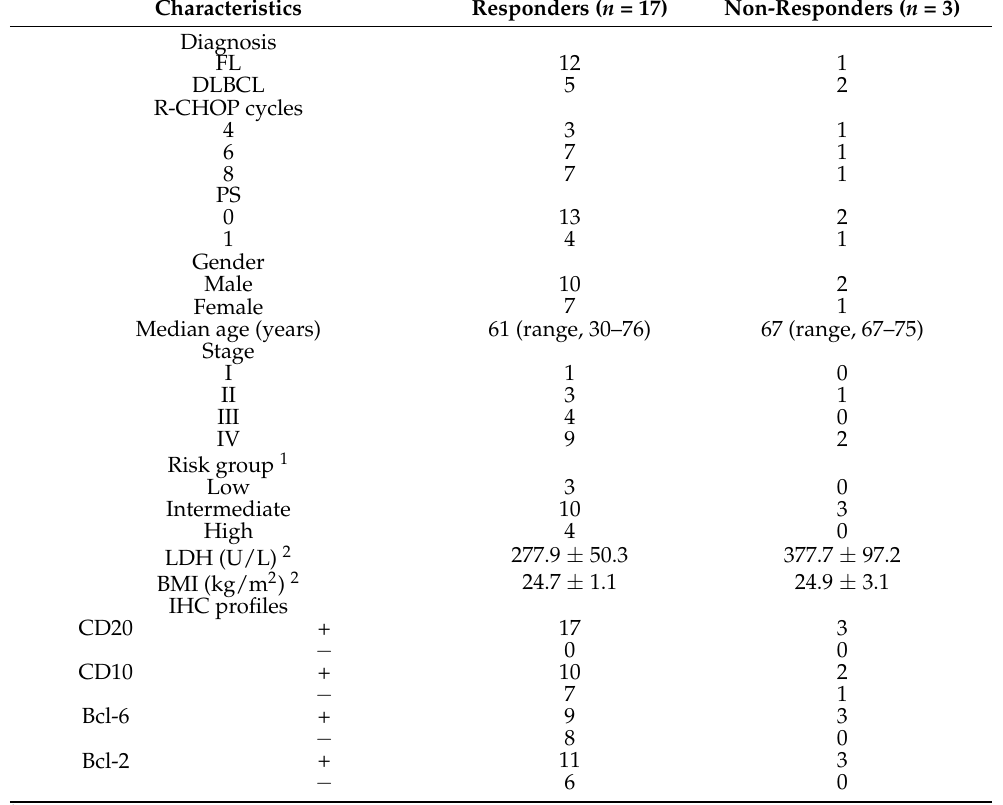
Table 1. Baseline characteristics and IHC profiles of the 20